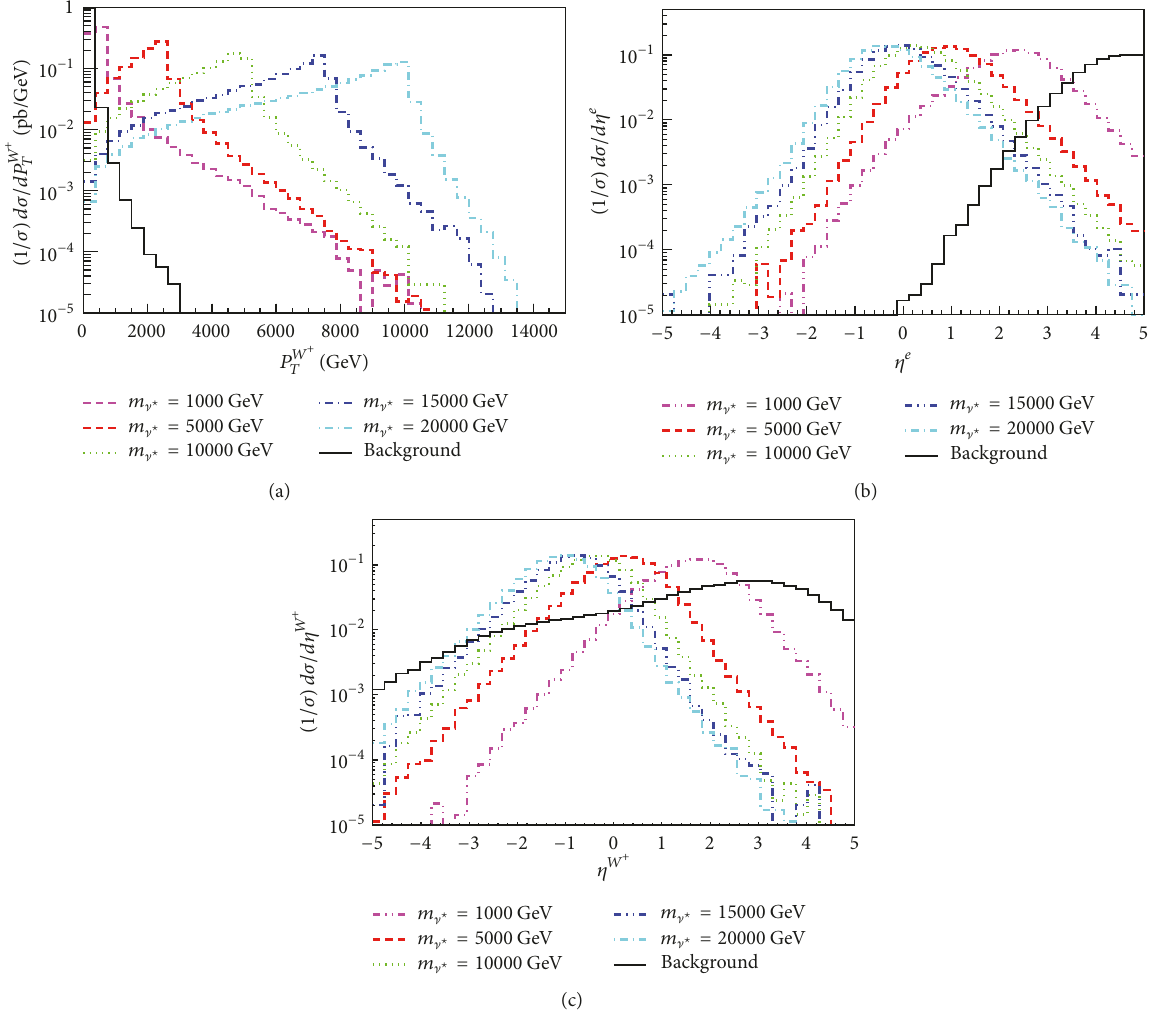
Figure 8: The normalized transverse momentum distributions of the final state 𝑊 + bosons (a), the normalized pseudorapidity distributions of the final state electrons (b), and the normalized pseudorapidity distributions of the final state 𝑊 + bosons (c) for 𝑓 = 𝑓 󸀠 = 1 and Λ = 𝑚 ] ⋆ at the PWFA-LC ⊗ FCC collider.